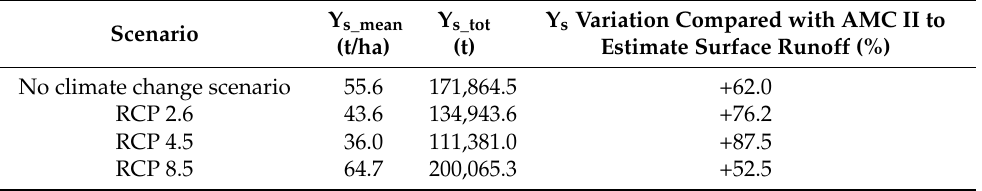
Table 9. Summary of the results: sediment yield generated by the 4 September 2011 rainfall event (MUSLE model) in the Guerna catchment, considering or not the effects of climate change (where AMC III was used to generate surface